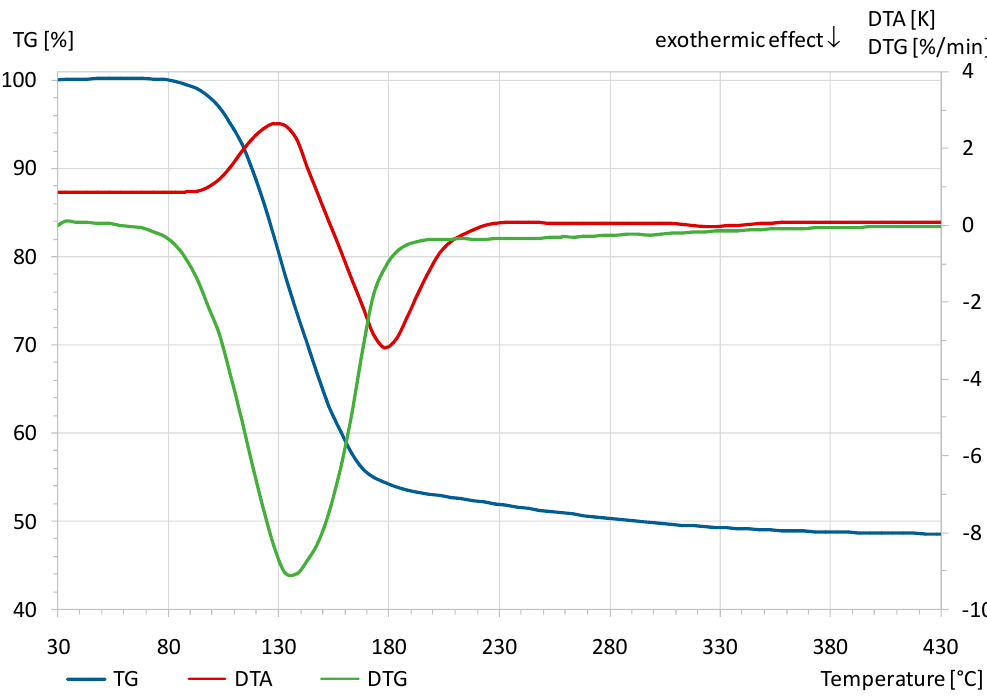
Figure 5. TG, DTA and DTG curves for struvite; the initial mass sample was 16.59 mg. The scale of the DTA and DTG curves is the same.